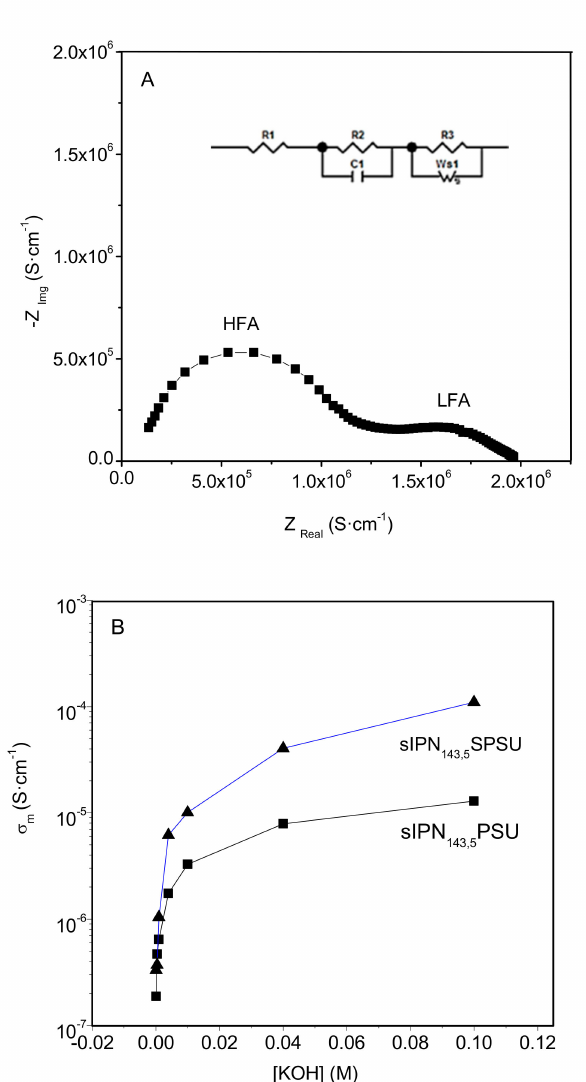
Figure 6. ( A ) Impedance plot of sIPN 75,5 -PSU-OH membrane and ( B ) Evolution of the OH − conduc- tivity of sIPN 143,5 -PSU-OH and sIPN 143,5 -SPSU-OH membranes as a function of the KOH concentra- tion. Measurements were performed at room